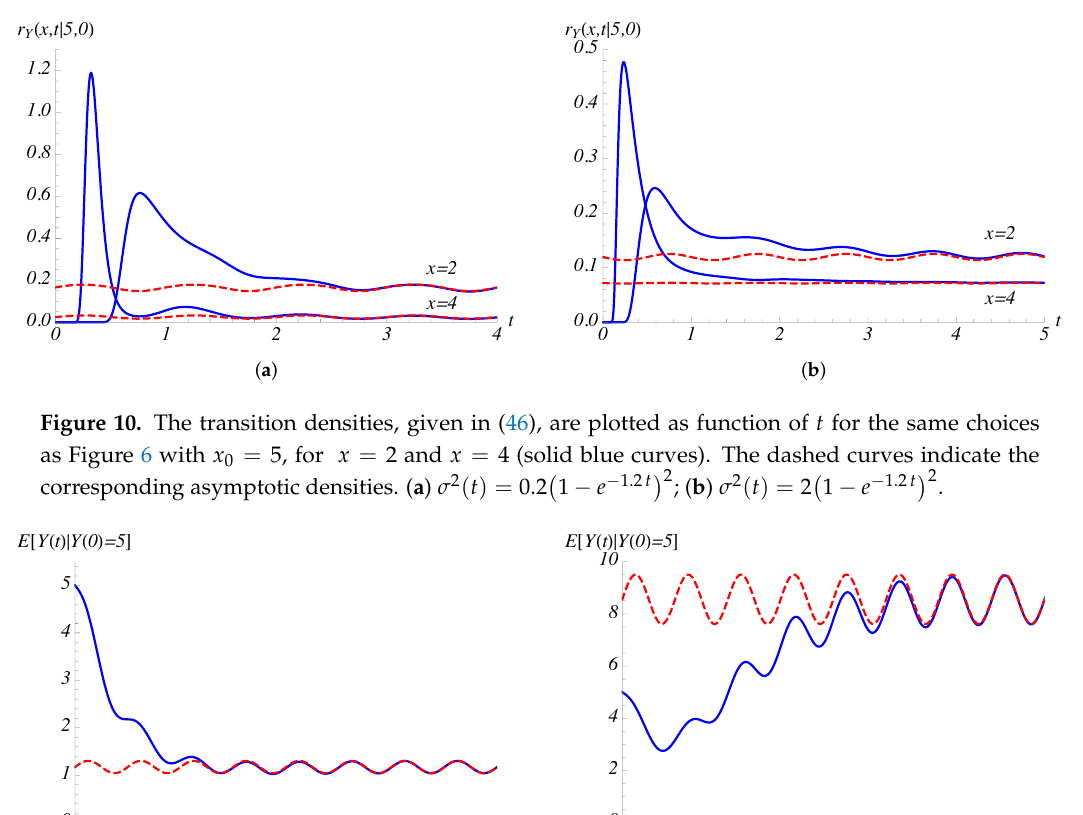
Figure 11. The conditional mean, given in (47), is compared with the corresponding asymptotic behavior (60) for the same choices as Figure 6 with x 0 = 5. ( a ) σ 2 ( t ) = 0.2 (cid:0) (cid:1) 2 2 1 − e − 1.2 t